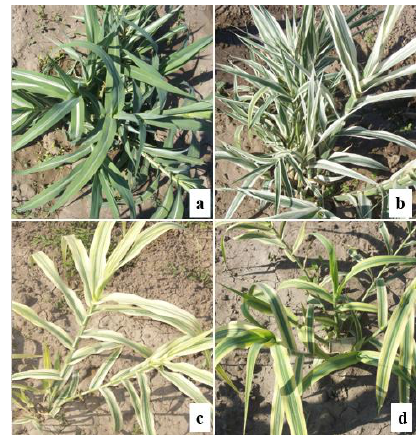
Figure 3. Leaf variants of striped giant reed originated from somatic embryogenesis (Debrecen, Hungary – July 2014) Source: photos by Gabriella Antal